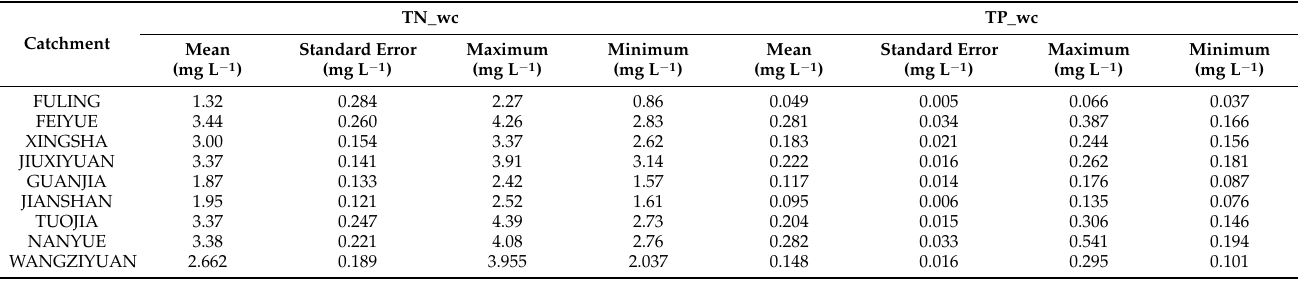
Table 2. Descriptive statistics of the stream flow-weighted total nitrogen (TN_wc) and total phospho- rus (TP_wc) concentrations observed from 2011 to 2016 in the nine studied